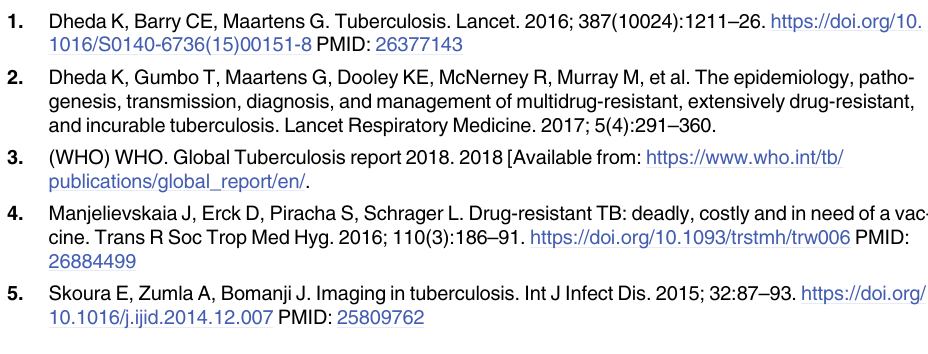
S4 Table. Proportional hazards test on the multivariate cox proportional hazards model. P-value corresponds to the statistical test of the cox.zph function that demonstrates that no individual variable nor global violates the proportional hazards test. S5 Table. Patient and condition ids for the cohort used for this analysis. A table of patient and condition ids is provided for the de-identified records that were used for this